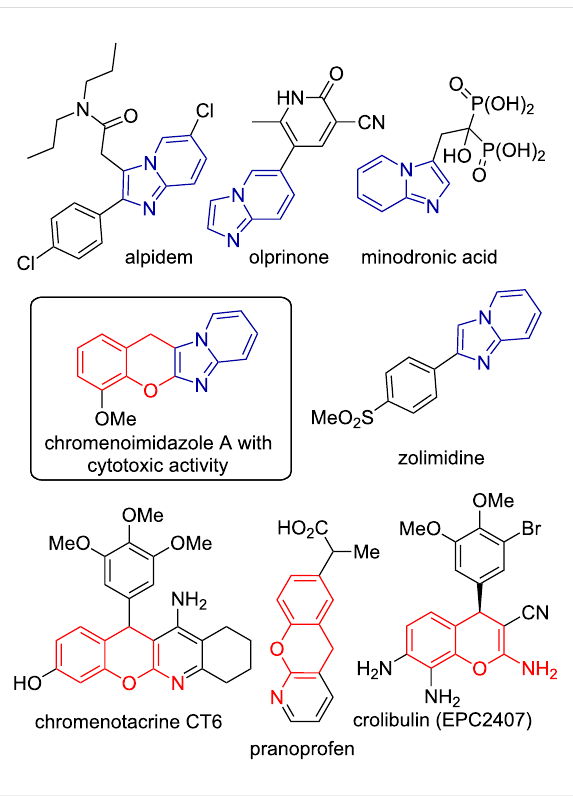
Figure 1: Biologically relevant imidazo[1,2- a ]pyridines and